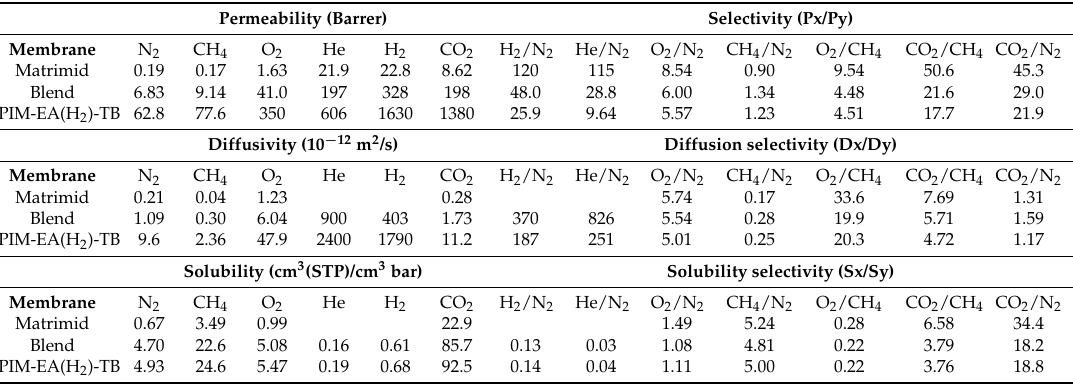
Table 1. Experimental data of single gas permeation in the neat polymers and the Matrimid ® 5218/PIM-EA(H 2 )-TB blend membrane. Permeability (Barrer) Selectivity (Px/Py)